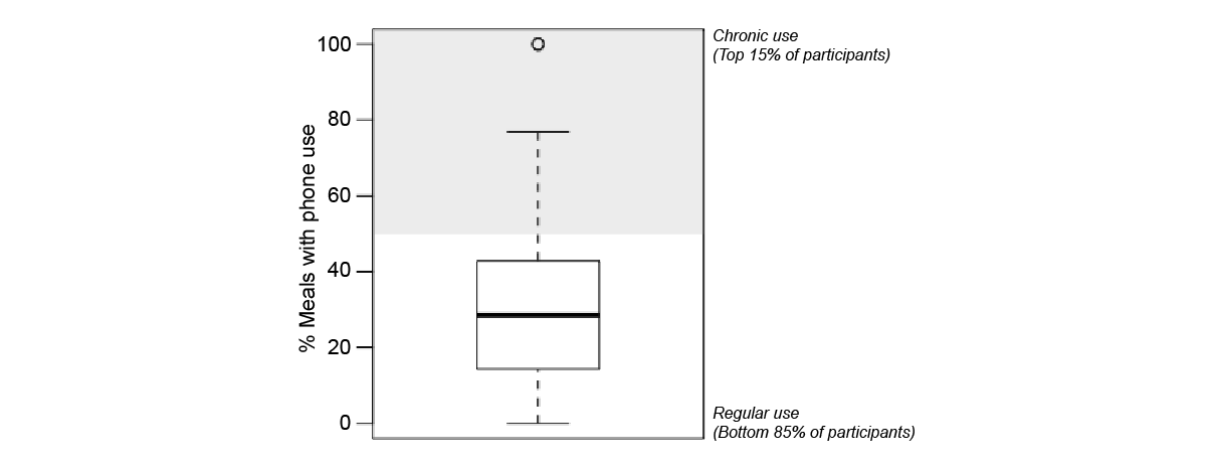
Figure 3. Box-plot depicting the distribution of mealtime phone use frequency captured across 1 week of naturalistic monitoring. The bottom, midline, and top of the box represent the 25th, 50th, and 75th percentiles, respectively, and chronic users are represented in the shaded gray area (top 15% of participants, corresponding to ≥ 50% of meals with phone